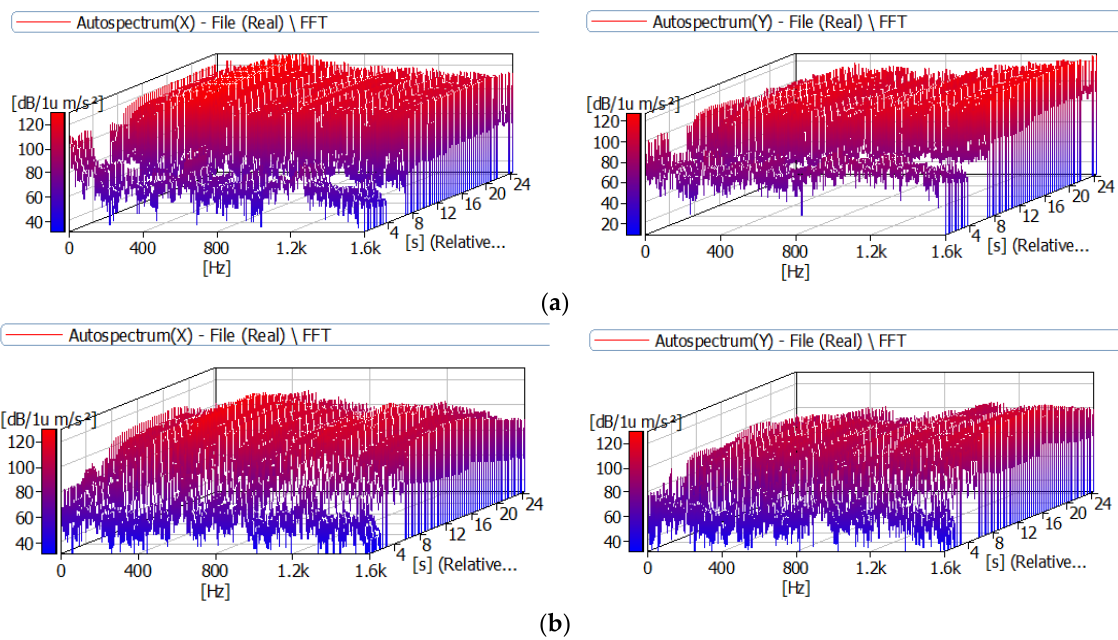
Figure 11. The vibration results at room ( a ) and heating at 200 °C ( b ) in the X and Y